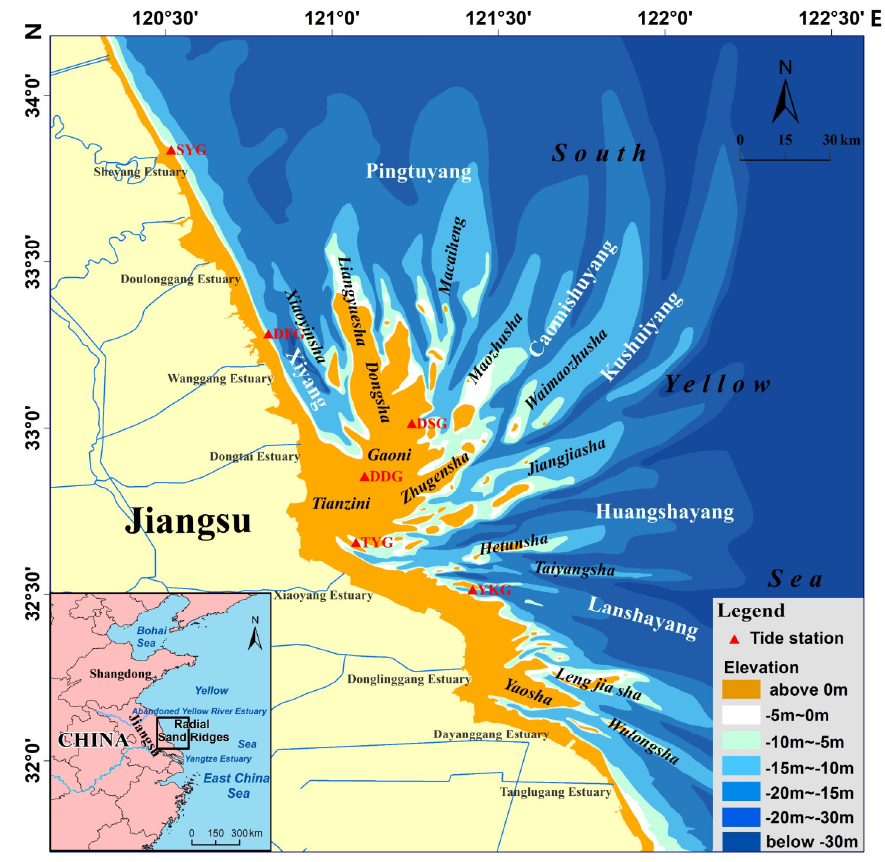
Figure 1. Location and topographic map of the RSRs. The RSRs area is affected by two tidal wave systems. One is the advancing tide wave from the East China Sea, which enters the Yellow Sea from south to north. The other is the counterclockwise rotating tide wave, which is formed by the reflection of the East China Sea advancing tide through the Shandong Peninsula. The two tidal waves meet in the RSRs, where the crest lines of the two tidal waves meet, forming a ‘standing wave’ area in the fan-shaped area outside the Tiaozini [32]. Therefore, tidal ranges are normally 4–6 m but can reach up to 9.36 m in the Tiaoyugang south of Tiaozini